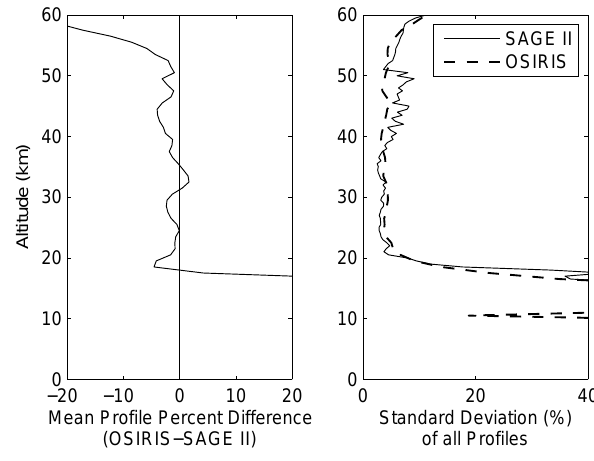
Fig. 7. The percent difference of the zonal average profile measured by OSIRIS and SAGE II over 24 h for a 5 degree tropical latitude band (15 SAGE II measurements and 26 OSIRIS